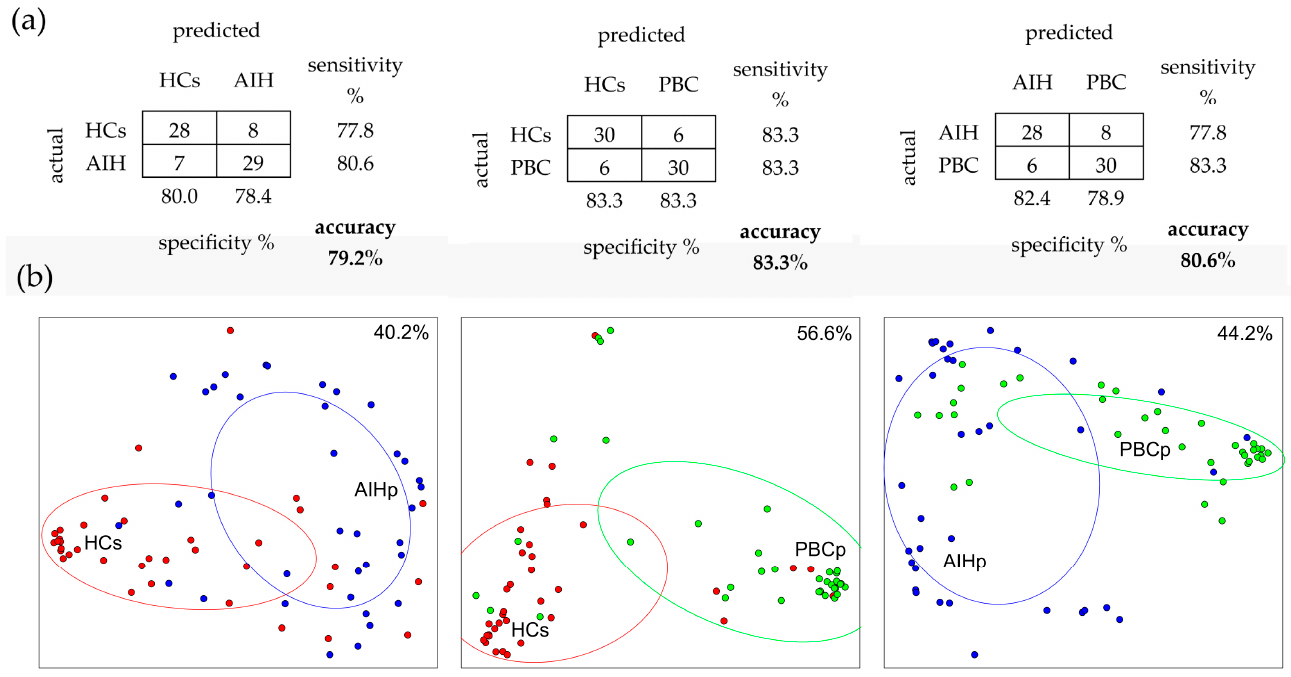
Figure 3. RF applied to three mixed data sets. ( a ) Confusion matrices of RF classifications validated by out-of-bag samples. Matrix rows represent the actual classes, while columns represent the predicted classes. Marginal rows show the frequency of false positives, while marginal columns show the frequency of false negatives. The overall accuracy considers both true positives and true negatives. ( b ) Multidimensional Scaling (MDS) diagrams showing the relationship among subjects, using the proximity values calculated by RF. Each group is delimited by a dispersion ellipse with a confidence of 1.6 standard deviations. Percent values indicate how much two-dimensional diagrams represent the information contained in the whole multi-dimensional